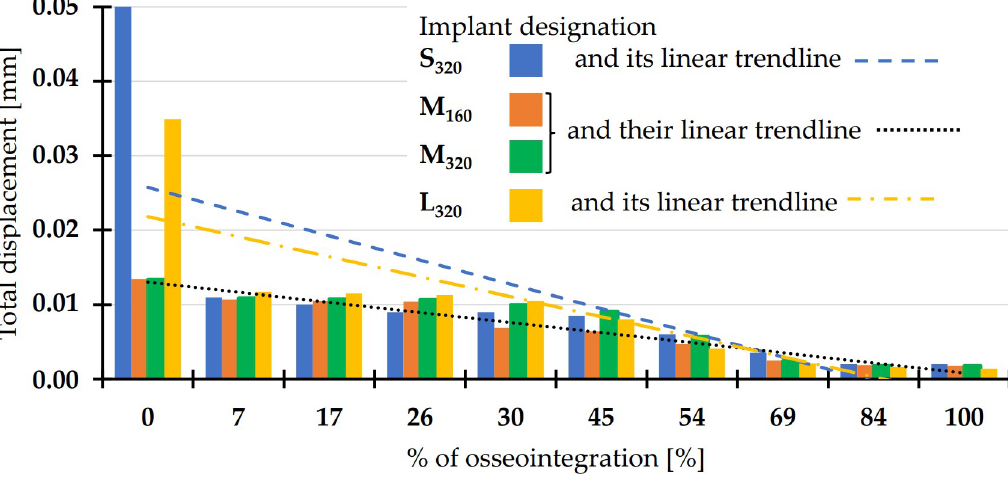
Fig 7. Reduction in the total implant displacements for different implant sizes with increasing osseointegration levels simulated in Approach II . The “% of osseointegration” was modeled by the percentage of the BIC surface area that was bonded.